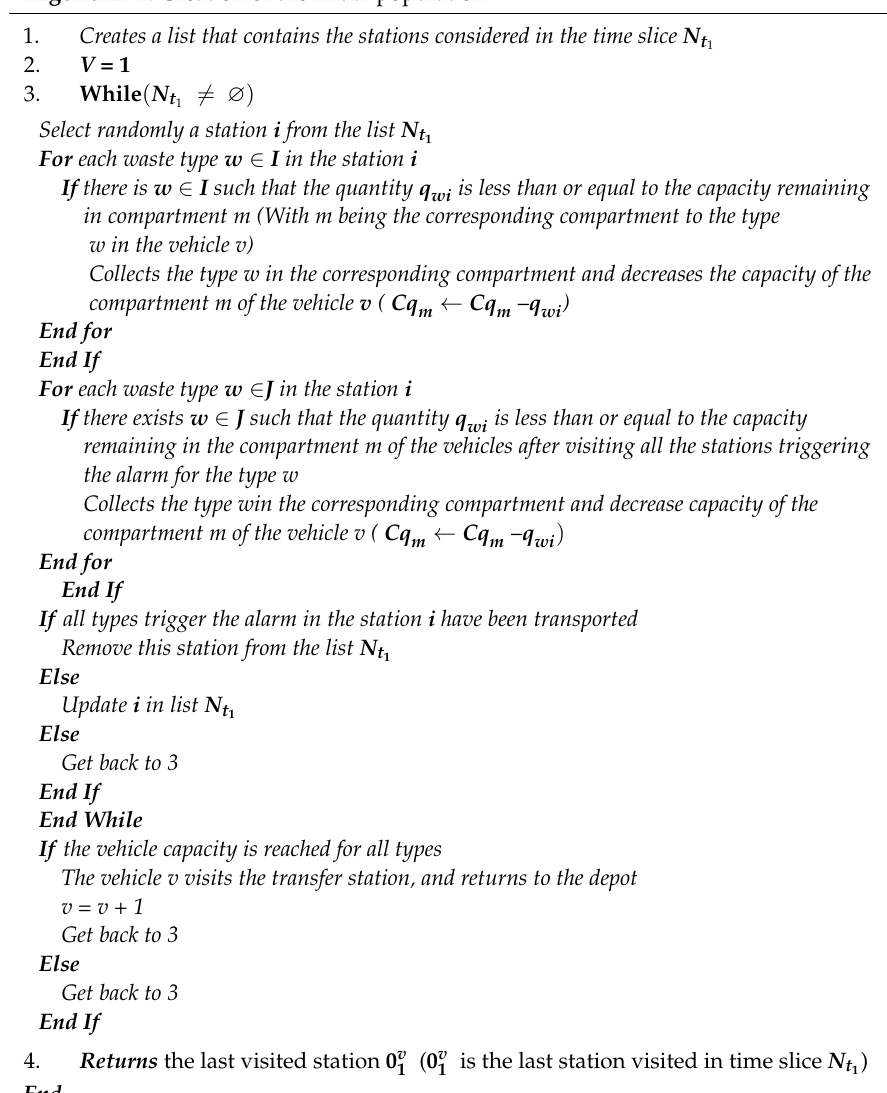
Algorithm 1: Creation of the initial